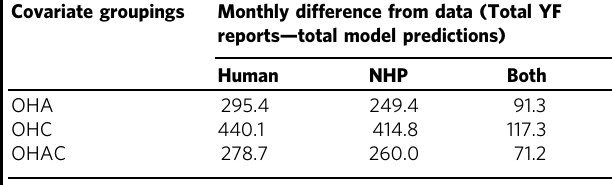
Table 3 Pearson ’ s correlation values comparing within- sample model predictions (for models fi tted to all the data) with the data by covariate